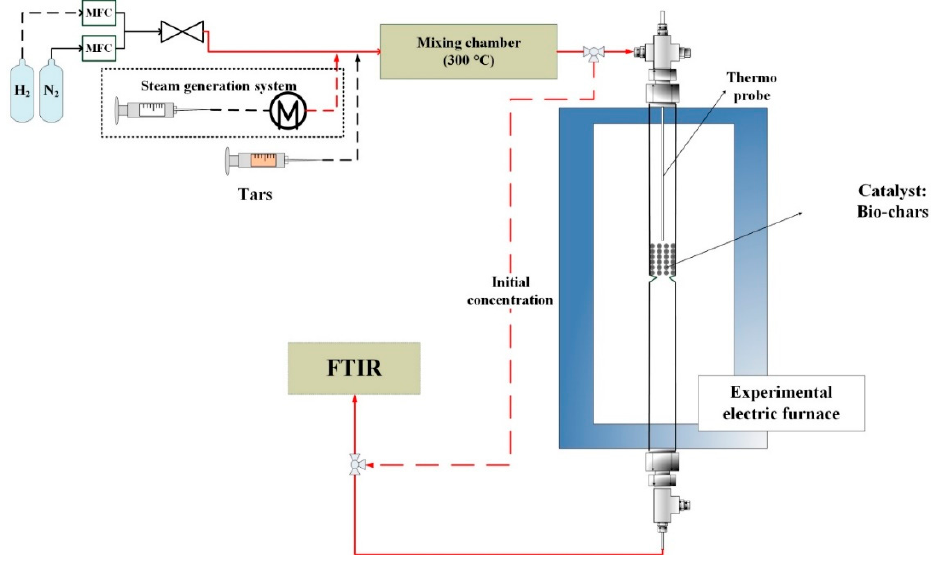
Figure 14. Diagram of tar reforming system.